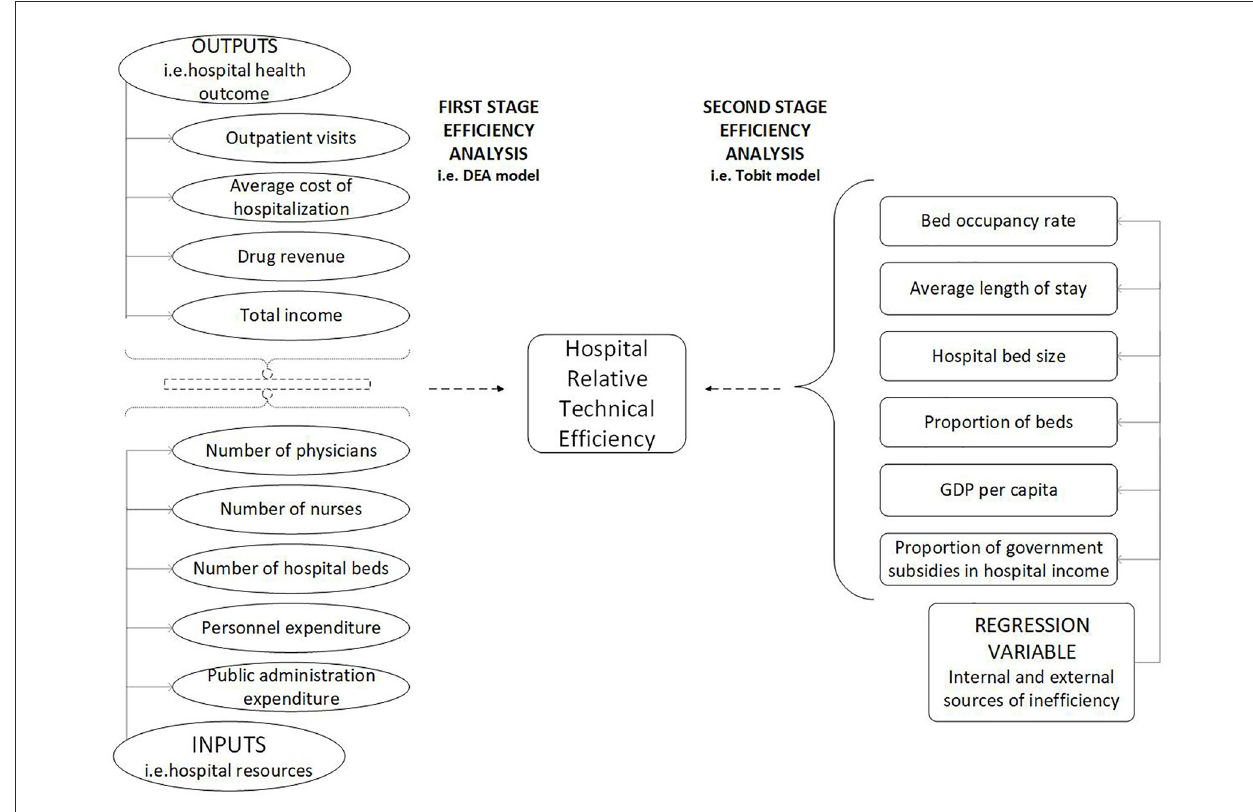
FIGURE2 Conceptual production structure diagram of hospitals.